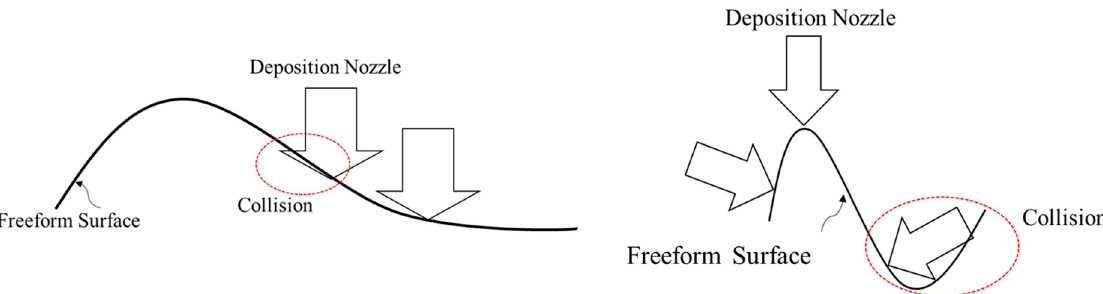
Figure 3. Local collision conditions.